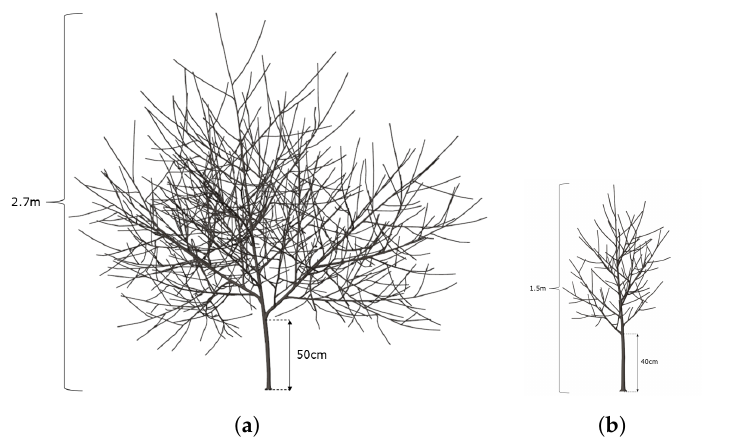
Figure 11. Tree growth with changing environmental temperature, fixed light source (top) and amount, 55° branching angle and 2 children branches. ( a ) 35 °C environment temperature; ( b ) 15 °C environment